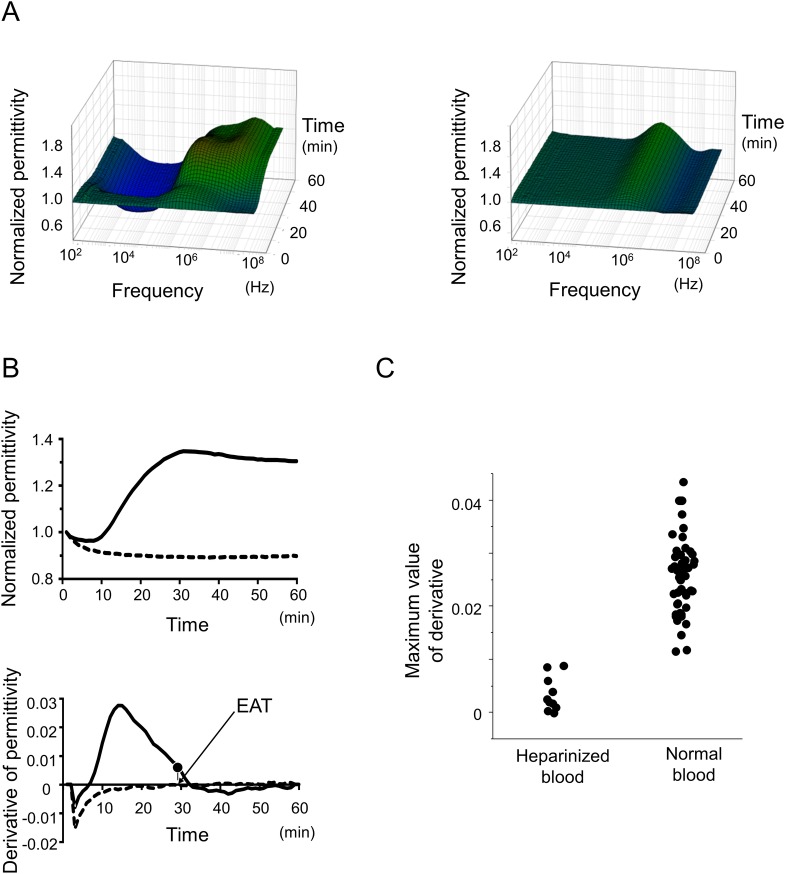
Temporal and spectral changes in the dielectric permittivity.(A) The normalized permittivity after recalcification is plotted from samples with a blood clot formation (left) or without coagulation in patients who underwent an intravenous heparin administration (heparinized samples) (right). The dielectric permittivity gradually increases at a range between 2.5 MHz and 16 MHz in samples with clot formation, whereas heparinized samples show no change in the permittivity in the same frequency range. (B) Representative traces of a normalized permittivity (top) and its derivative (bottom) at 10 MHz plotted against the time from recalcification. The solid line represents the trace from a normal sample with blood clot formation, and the dotted line is that from a heparinized sample without clot formation. The temporal changes in the dielectric permittivity demonstrate a sigmoidal increase, and its derivative shows a single peak in the normal sample. The heparinized sample exhibits no increase in the permittivity, as well as the derivative. The end of acceleration time (EAT) was defined as the time at which the derivative of the permittivity reached the 10% value in the descending phase. (C) The maximum value of the derivative of the dielectric permittivity was plotted in normal samples with a blood clot formation and heparinized sample without clot formation (n = 50 for normals, and 10 for heparinized samples).